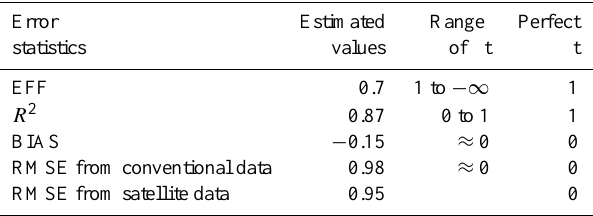
Figure 3. Annual (October to September) RDI of Larissa for 1981-200. 23